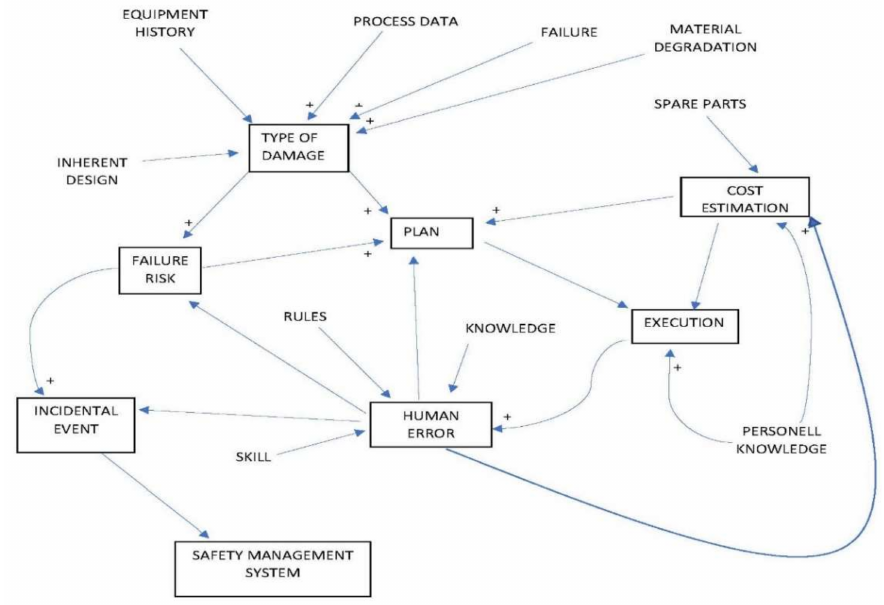
Figure 1. Causal loop diagram of the Bhopal